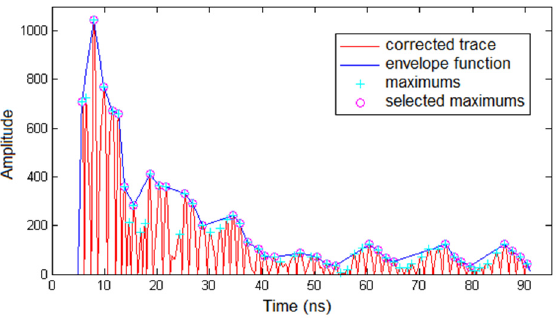
Figure 8. Envelope function fitted to the absolute values of the amplitudes.